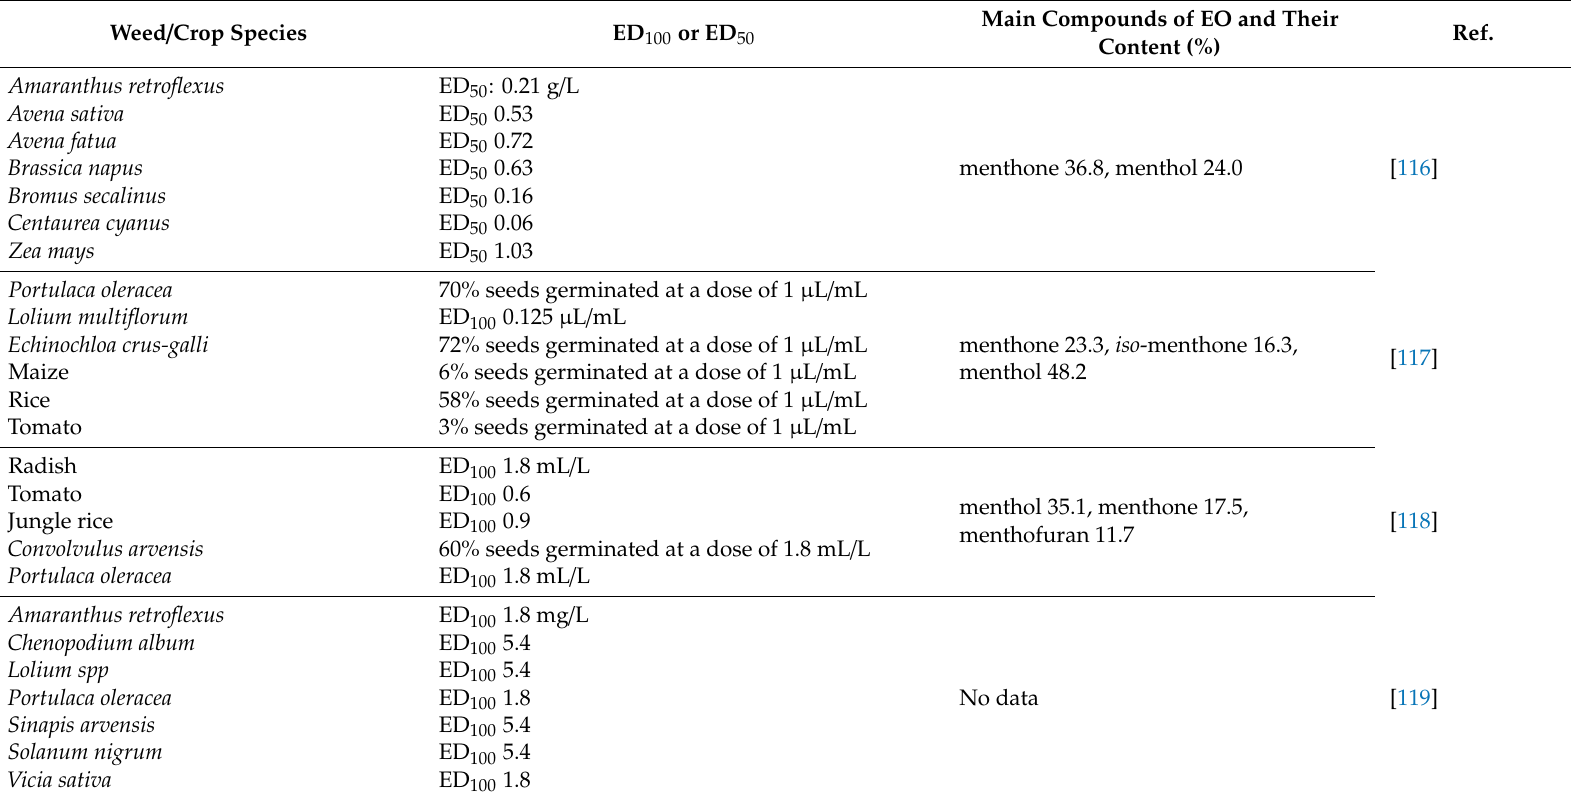
Main Compounds of EO and Their Content (%)